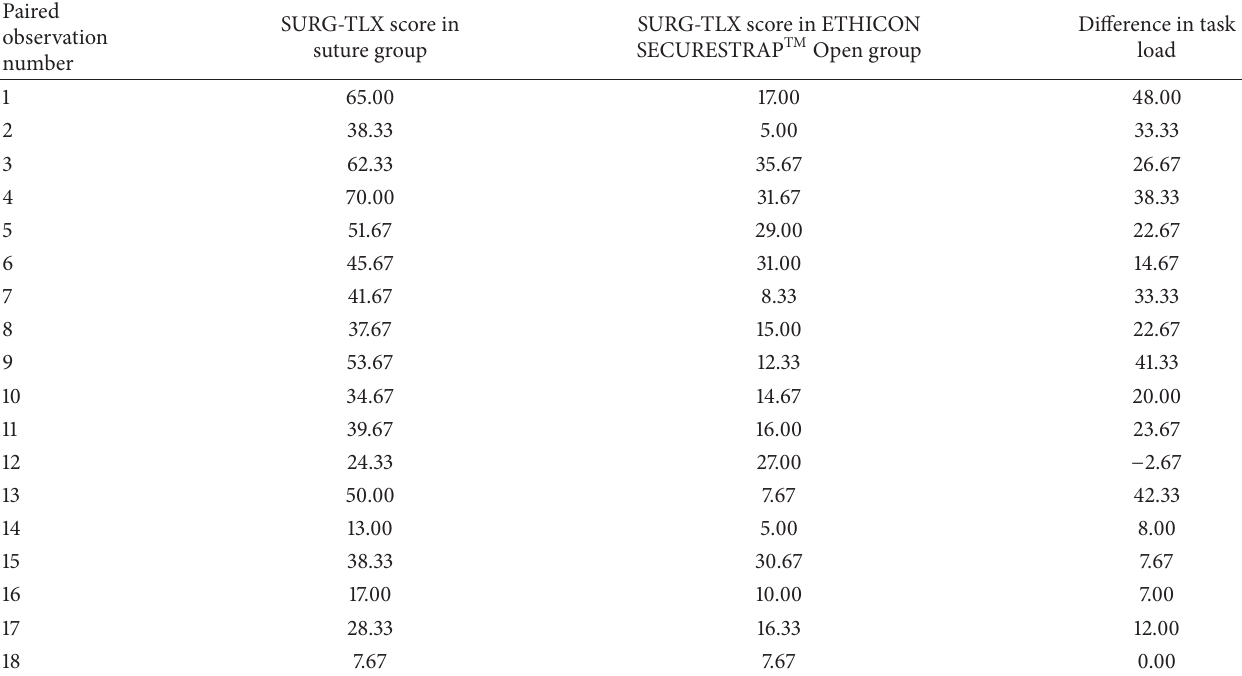
Table 2: Difference in surgery task load between suture and mechanical fixation